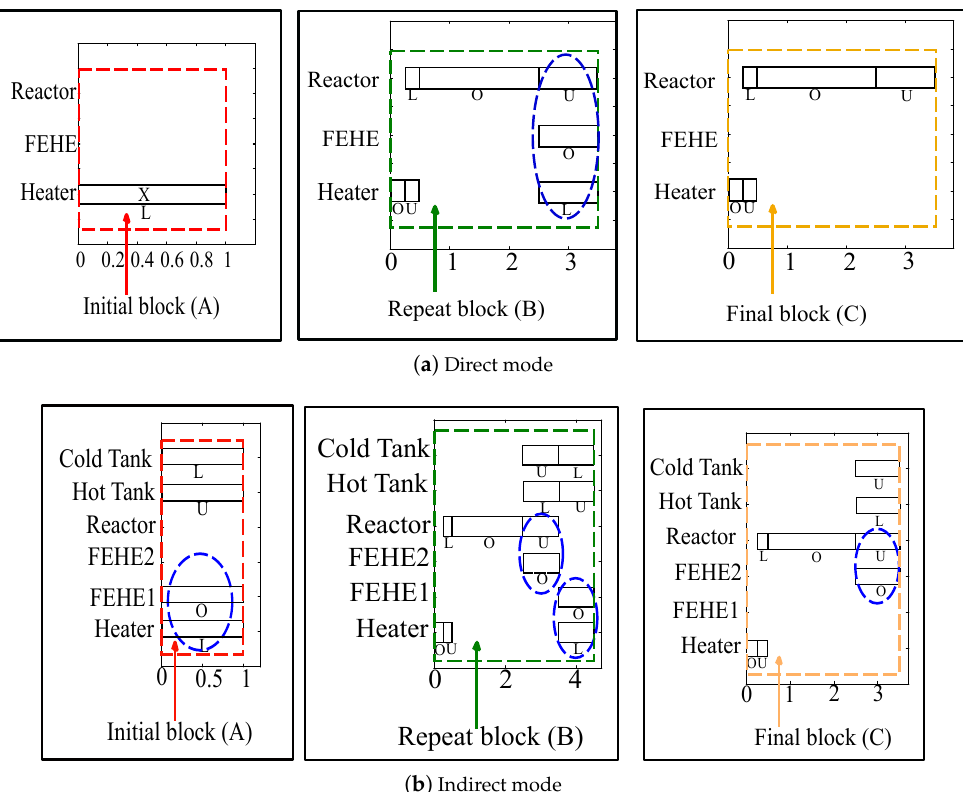
Figure 3. Fundamental building blocks for optimal schedule of BR-FEHE system.